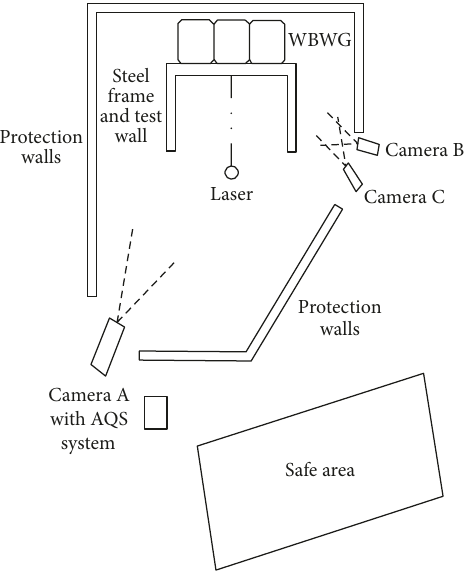
Figure 5: Detail of experimental set-up.